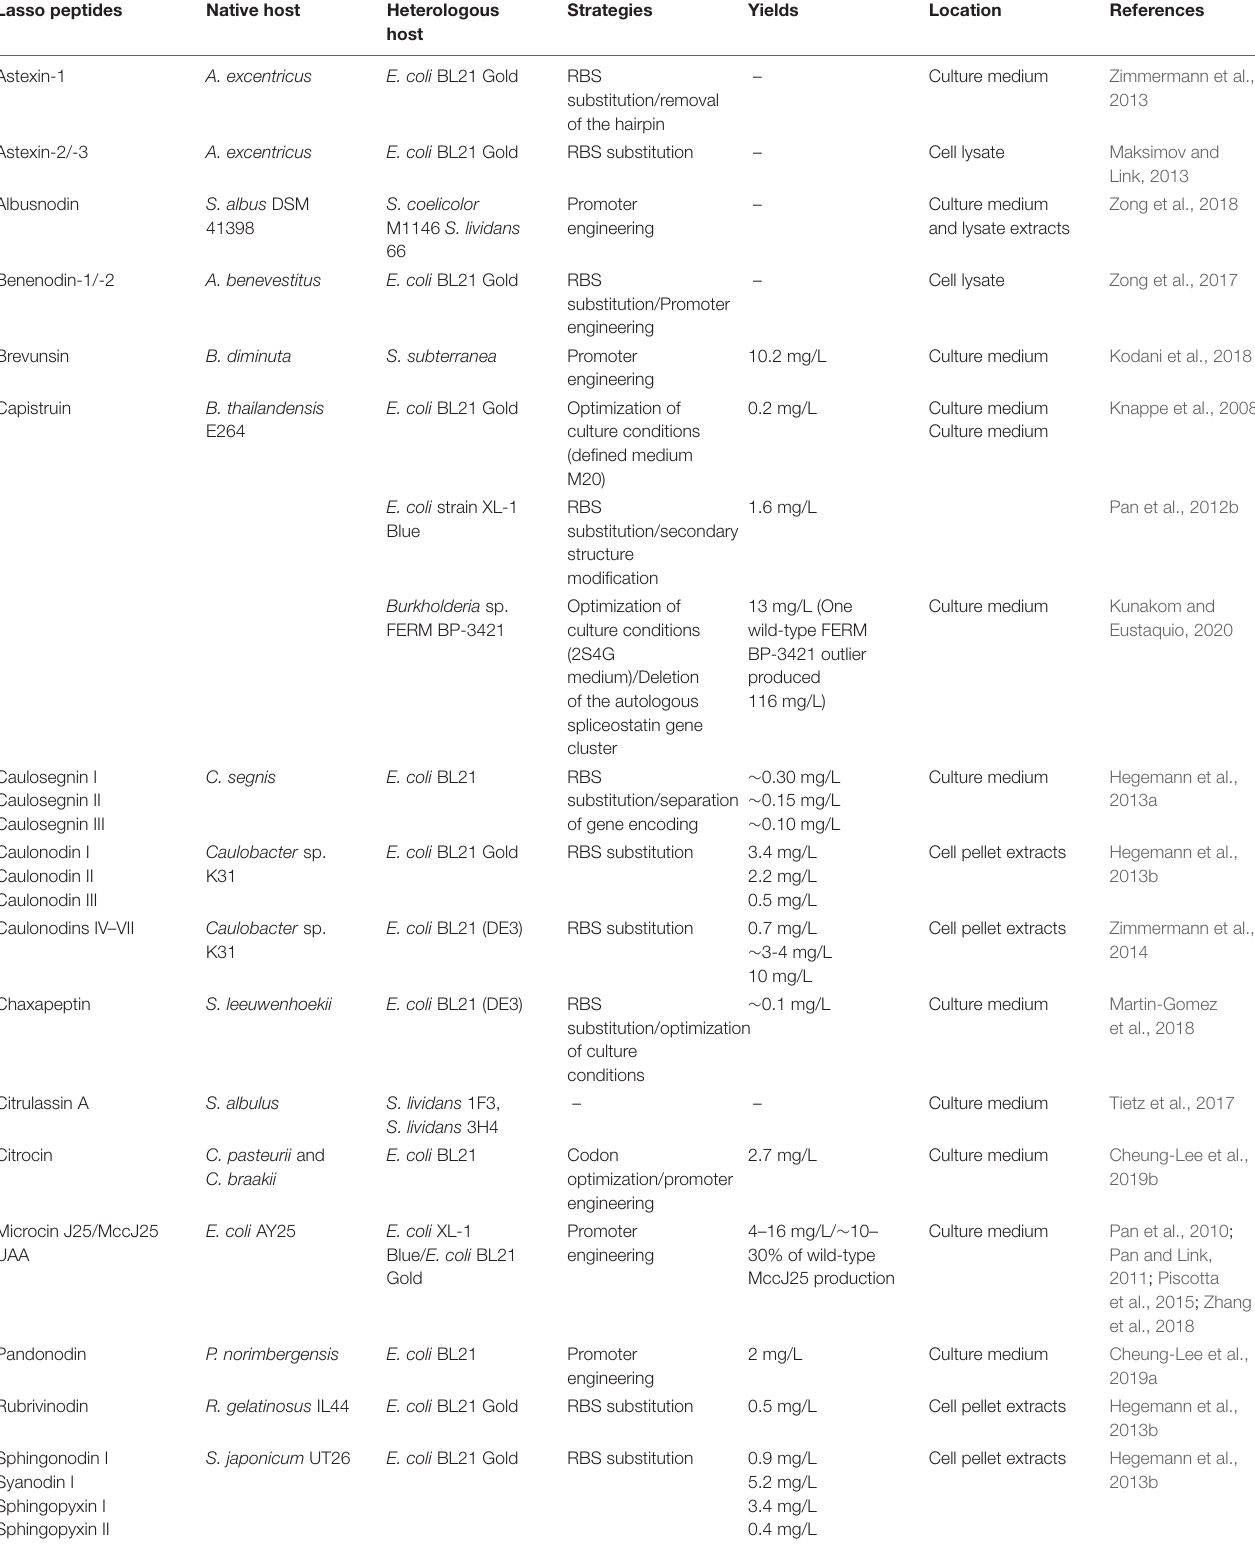
TABLE 2 | Heterologous expression of commonly known lasso